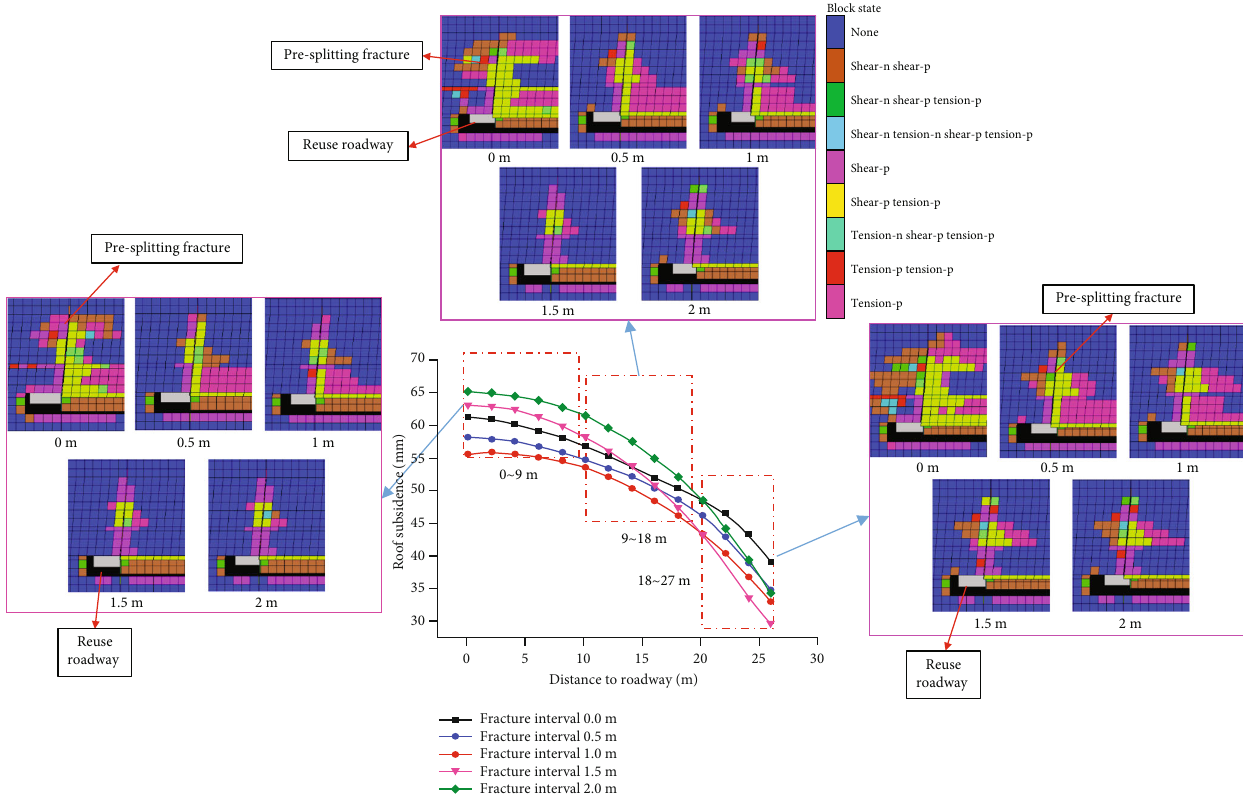
Figure 8: Deformation curves and plastic damage distribution characteristics of surrounding reused roadway